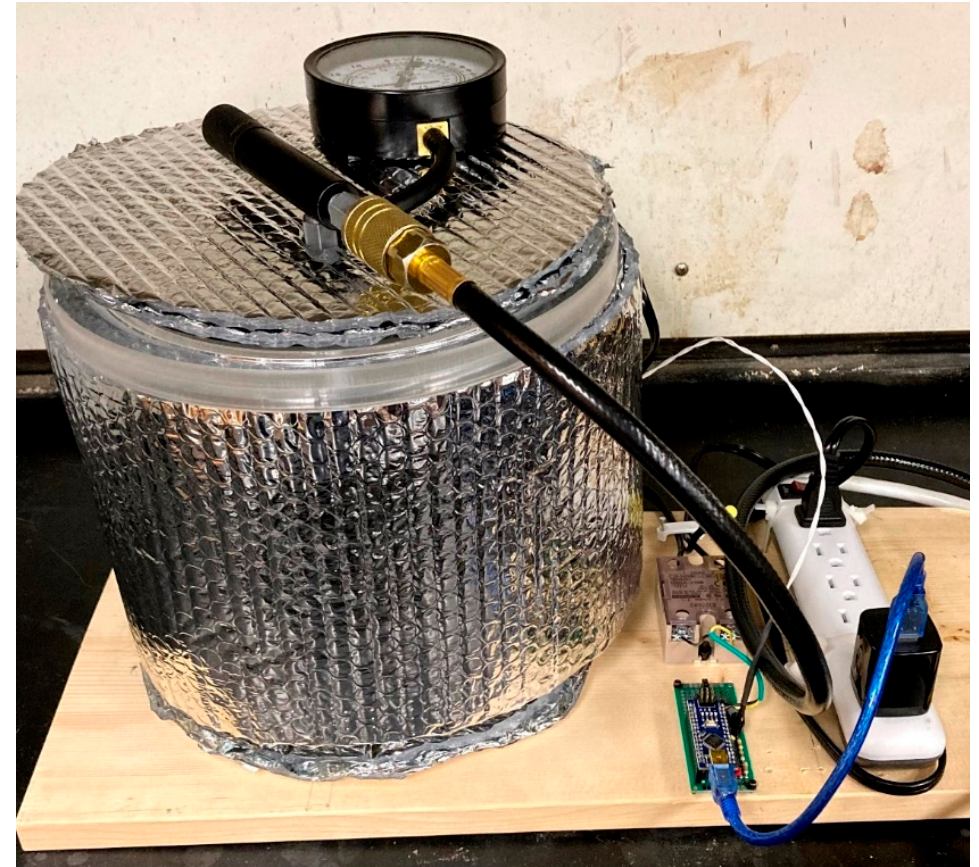
Figure 14. The fully assembled vacuum oven.